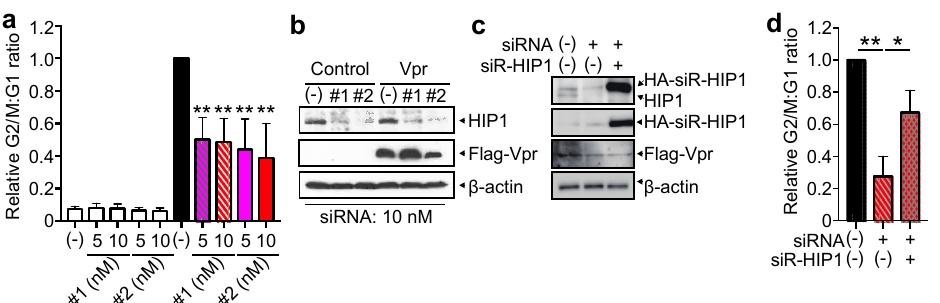
Figure 2. HIP1 enhances Vpr-induced G2 arrest. ( a , b ) HeLa cells were co-transfected with pME/F- Vpr-IRES-ZsGreen1 or control pME/F-IRES-ZsGreen1 and 5 or 10 nM either HIP1 (siRNA#1 and #2) or control siRNA and cultured for 48 h. ( a ) Cells were fixed and stained with 5 µ g/mL Hoechst33342 to measure DNA content in ZsGreen1+ cells using CELAVIEW RS100. The relative G2/M:G1 ratio was plotted, and data represent the mean ± SD of three independent experiments. ( b ) Cells were lysed and subjected to 6% and 15% SDS-PAGE and Western blot using an anti-HIP1 mAb, anti-Flag M2 mAb, and anti- β -actin mAb. ( c , d ) HeLa cells were co-transfected with pME/F-Vpr-IRES-ZsGreen1 and pCAGGS/HA-siR-HIP1 (carrying synonymous nucleotide mutations at the third codon of the siRNA-targeting site) or control pCAGGS/HA and either 10 nM HIP1 (siRNA#2) or control siRNA and then cultured for 48 h. ( c ) Cells were lysed and subjected to 6% and 15% SDS-PAGE and Western blot using an anti-HIP1 mAb, anti-Flag M2 mAb, anti-HA mAb, and anti- β -actin mAb. ( d ) Cells were fixed, permeabilized, stained with the anti-HA mAb, and then with Alexa Fluor 594-conjugated secondary Ab and Hoechst33342. The DNA content of ZsGreen1+ and Alexa Fluor 594+ cells was analyzed by CELAVIEW RS100. The relative G2/M:G1 ratio was plotted, and data represent the mean ± SD of three independent experiments. * p < 0.05, ** p < 0.01 via two-tailed Student’s t -test.